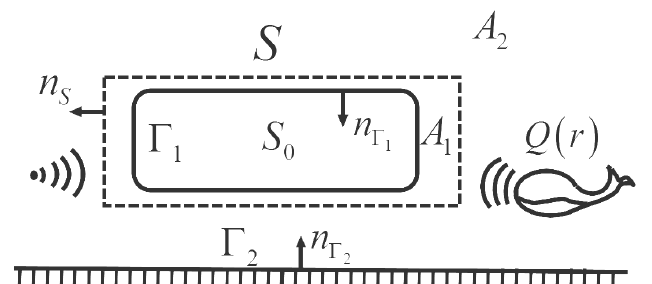
Figure 2. Geometry of a vibrating structure in a complex underwater